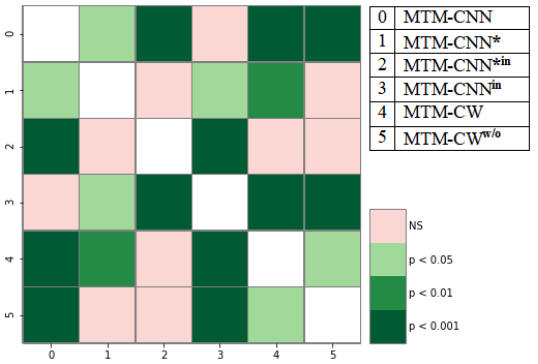
Figure 9. Post hoc pairwise analysis of Friedman’s test for MTM-CNN vs. MTM-CW.